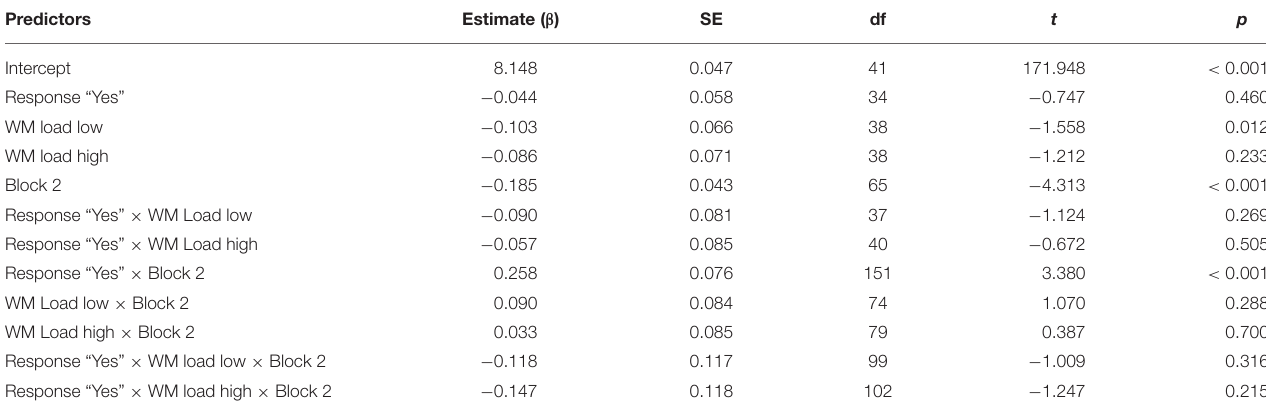
TABLE 6 | Overview of the model comparing the response times of the “yes” and “no” responses in condition Each-Collective, with reference levels: Response: “No,” WM Load: “No Load,” and Block: 1.